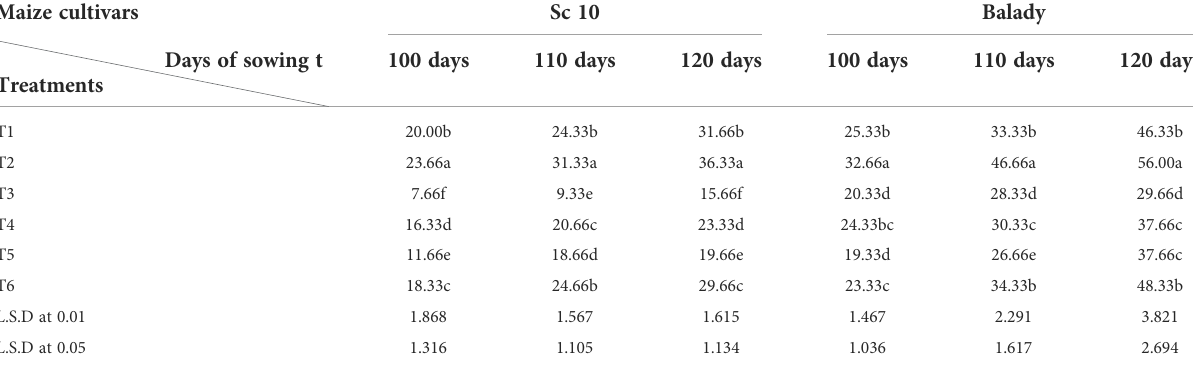
TABLE 9 Fusarium verticillioides frequency % from kernels under different soil treatments at different times after sowing during the 2021 growing season. Maize cultivars Sc